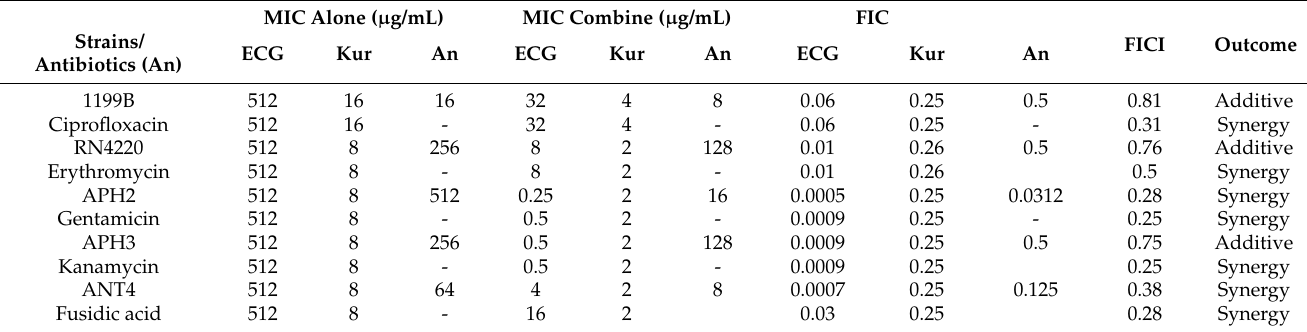
Table 2. Minimum inhibitory concentrations (MIC) ( µ g/mL) and fractional inhibitory concentration indices (FICI) of kuraridin (Kur) and epicatechin gallate (ECG) with or without antibiotics against the laboratory S. aureus strains with known antibiotic-resistant